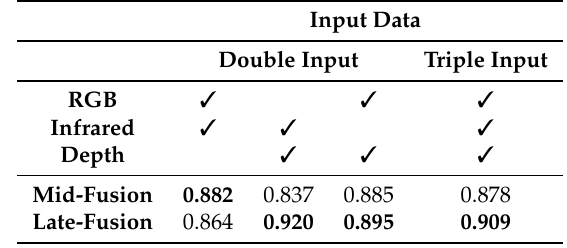
Table 6. Comparison of different fusion strategies for different types of data.